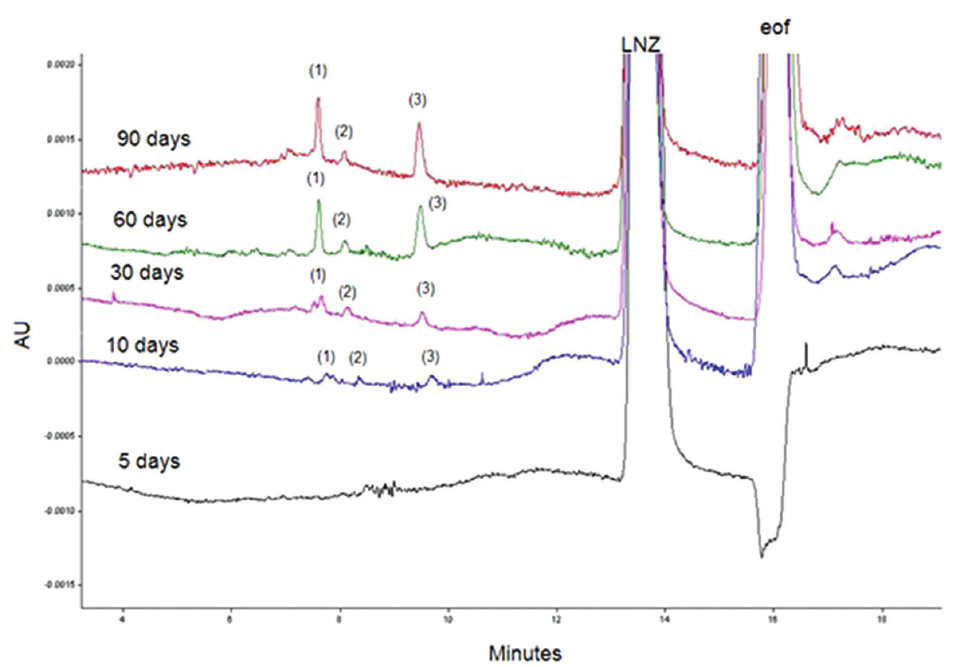
FIGURE 3 - Electropherogram of photodegradation products of LNZ tablet submitted to light UVC (254 nm).